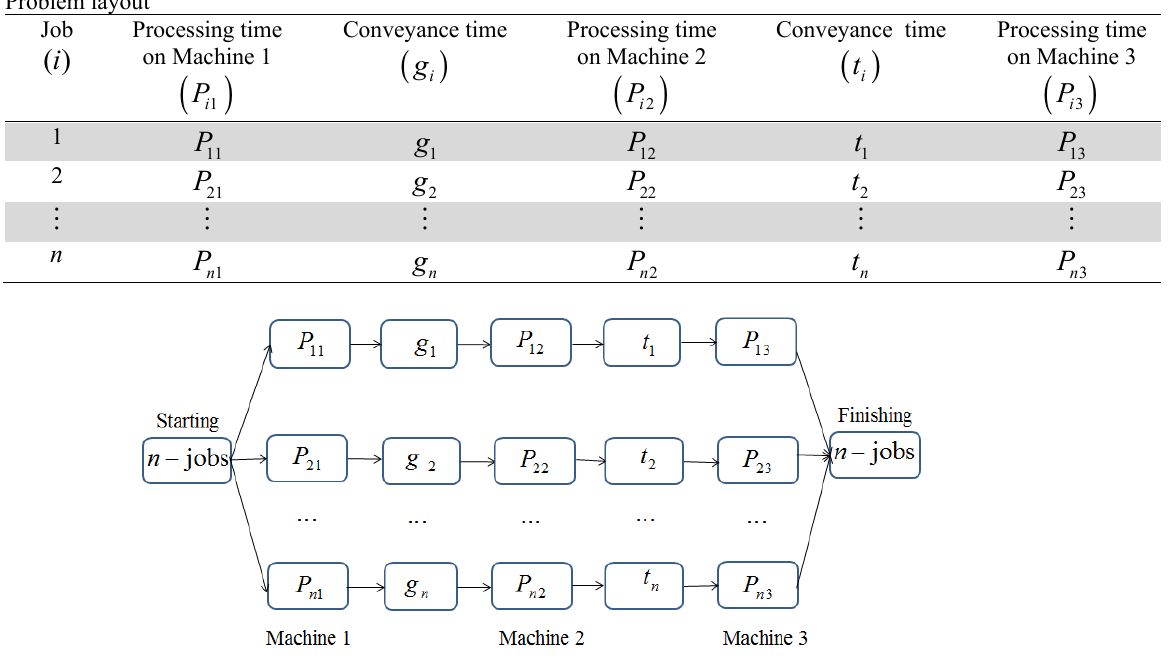
Fig. 1 Schematic representation of the present